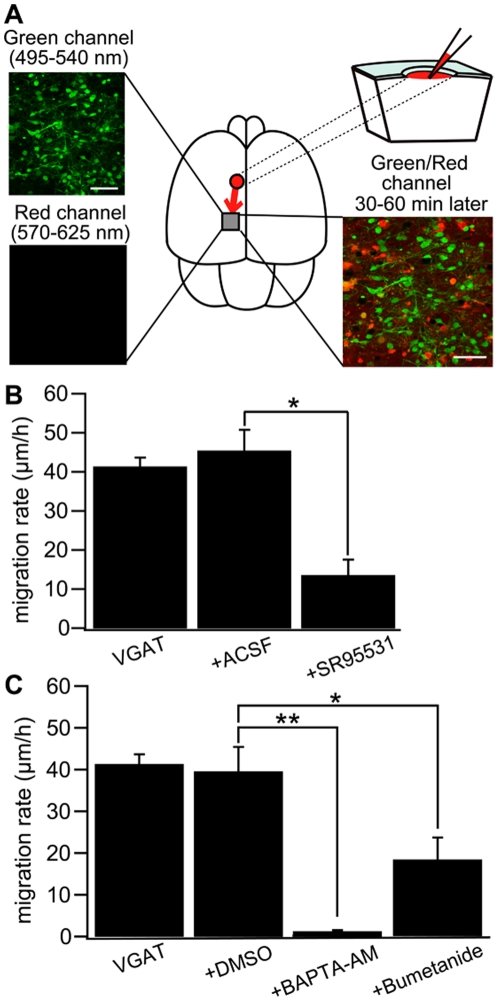

In vivo drug application in immature cortex.(A) Upper left: Two-photon image of Venus positive cells immediately after drug application in a P0 VGAT-Venus mouse. Making a hole at 1–2 mm away from the observed area has no effect on the morphology of the cells within imaging area. Scale bar = 50 µm. Lower left: Two-photon image of sulforhodamine 101 (SR101) showing that the drug does not reach the imaging area immediately after injection. Upper right: Schematic drawing of the drug injection procedure; making a hole and injecting the drug conjugated with SR101. The drug diffuses into the imaging area after 30–60 minutes of injection. Lower right: Two-photon image of Venus-positive cells and SR101 showing that the pipette solution spread around the cells without injuring them. Scale bar = 50 µm (B) Cell displacement during 1 hour of migration for neurons in VGAT-Venus without drug application (VGAT), after injection of ACSF (+ ACSF) and after injection of SR95531 (+SR95531). The selective GABAAR antagonist (SR95531, 1 mM, 1 µl) reduced the migration rate significantly (*p<0.05) whereas ACSF (1 µl) had no effect. (C) DMSO (1 µl) had no effect on cell displacement. Chelating intracellular Ca2+ by BAPTA-AM (2 mM, 1 µl) conjugated with DMSO almost completely inhibited the migration (**p<0.01) and blockade of NKCC by bumetanide (1 mM, 1 µl) significantly reduced the migration rate (*p<0.05). VGAT-Venus; n = 5 animals, ACSF; n = 5 animals, DMSO; n = 4 animals, SR95531; n = 5 animals, bumetanide; n = 4 animals, BAPTA-AM; n = 4 animals. All animals were used at P0–P3, except the bumetanide group which were used at P1–P3. Each column in B and C indicates mean ± SEM.